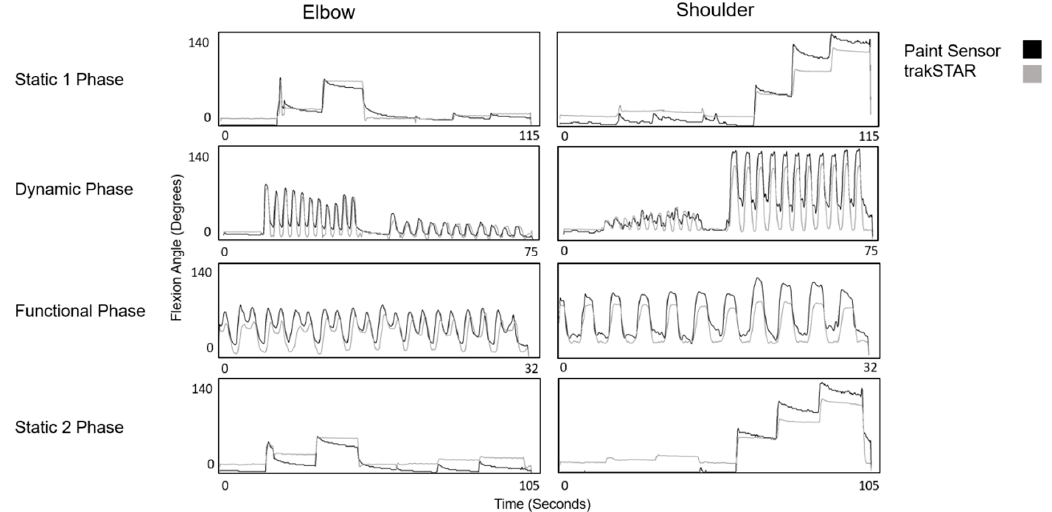
Figure 4. Graphs comparing data between the smart compression garment and trakSTAR from all phases for one trial